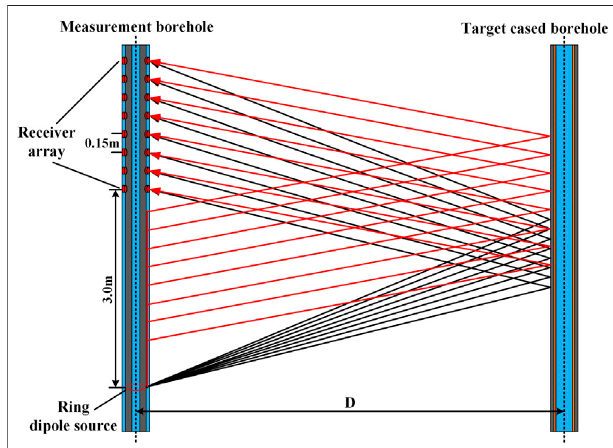
FIGURE 10 | Schematic of the detection of a nearby cased borehole with a ring dipole source in LWD. The red and black lines represent the propagation paths of Mach waves and P-(S-) waves, respectively.